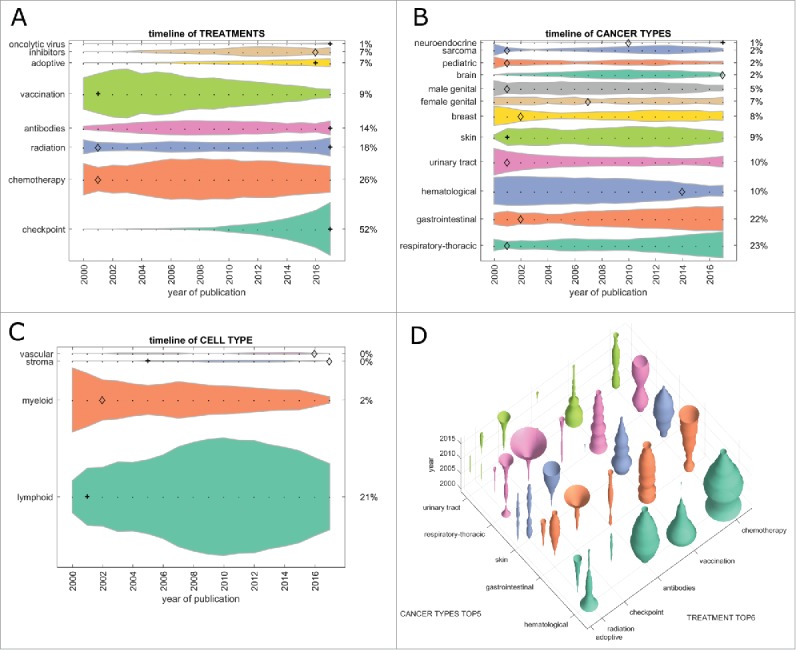
Trends in clinical trials from 2000 to 2017 per topic. This Fig. summarizes all registered clinical trials of cancer immunotherapy grouped by category. (A) Immune checkpoint inhibition has rapidly become the most common therapy approach between 2010 and 2017. At the same time, vaccination approaches have greatly diminished, being subject to only 9% of clinical immunotherapy trials in 2017. (B) As in PubMed publications, hematological neoplasms have markedly lost ground, yielding to gastrointestinal and respiratory neoplasms in recent years. (C) Among all major cell types in the tumor microenvironment, myeloid cells were in the focus of research interest around 2000, diminishing afterwards and only being investigated in 2% of immunotherapy clinical trials in 2017. (D) Bivariate plot of treatment types versus cancer types in cancer immunotherapy clinical trials. Checkpoint inhibition shows an increasing trend (“trumpet”) in respiratory and gastrointestinal cancer. (A-C) + significant rise of growth rate within one year (anomaly >95%), ◊ significant decrease of one-year growth rate (anomaly < 5%).